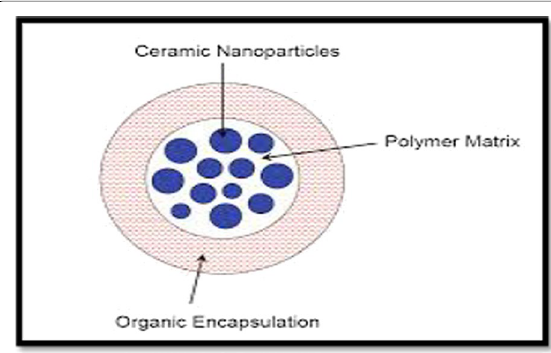
Fig. 5 Schematic representation of ceramic nanoparticles